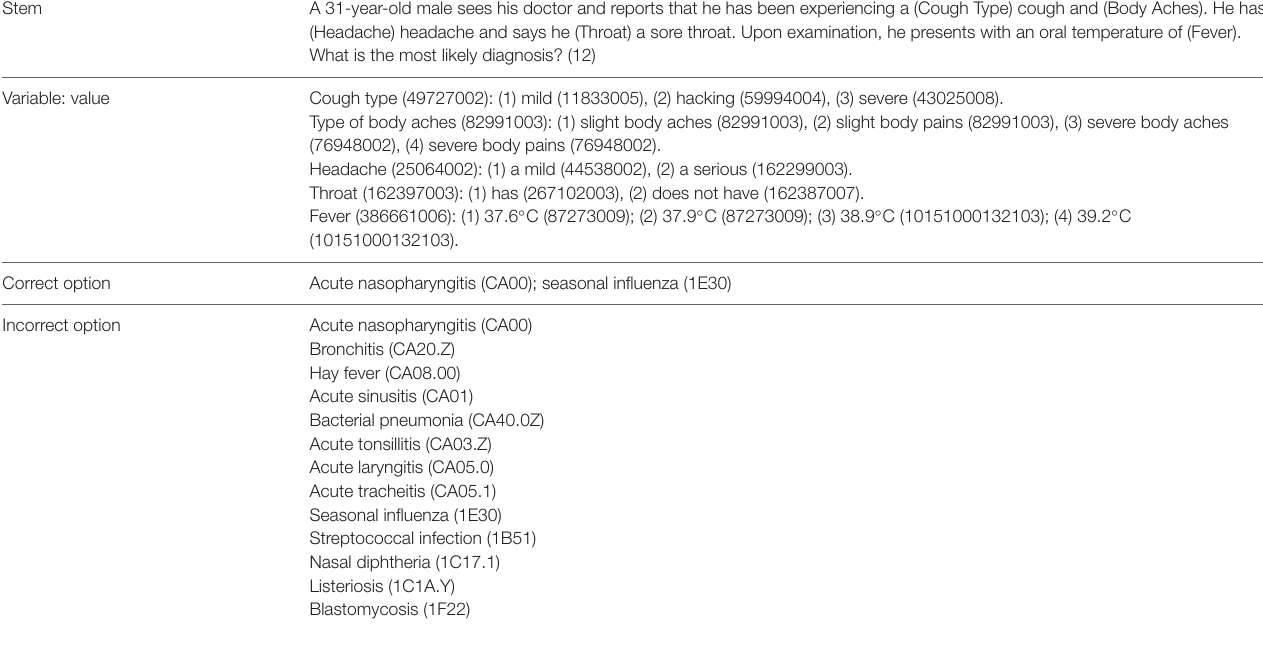
TABLE 3 | Medical item model with content